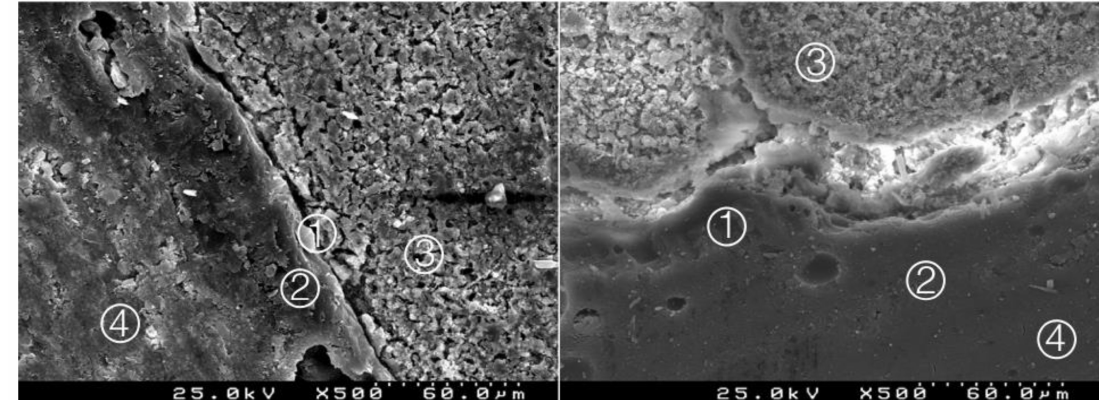
Figure 12. Group 10 (NeoMTASE07): less deep interdigitation between the adhesive and the cement. A thin interdiffusion layer is observed 1 (cid:13) between the adhesive 2 (cid:13) and the NuSmile ® NeoMTA 3 (cid:13) . Composite resin 4 (cid:13) (original magnification 500 × and 1000 ×